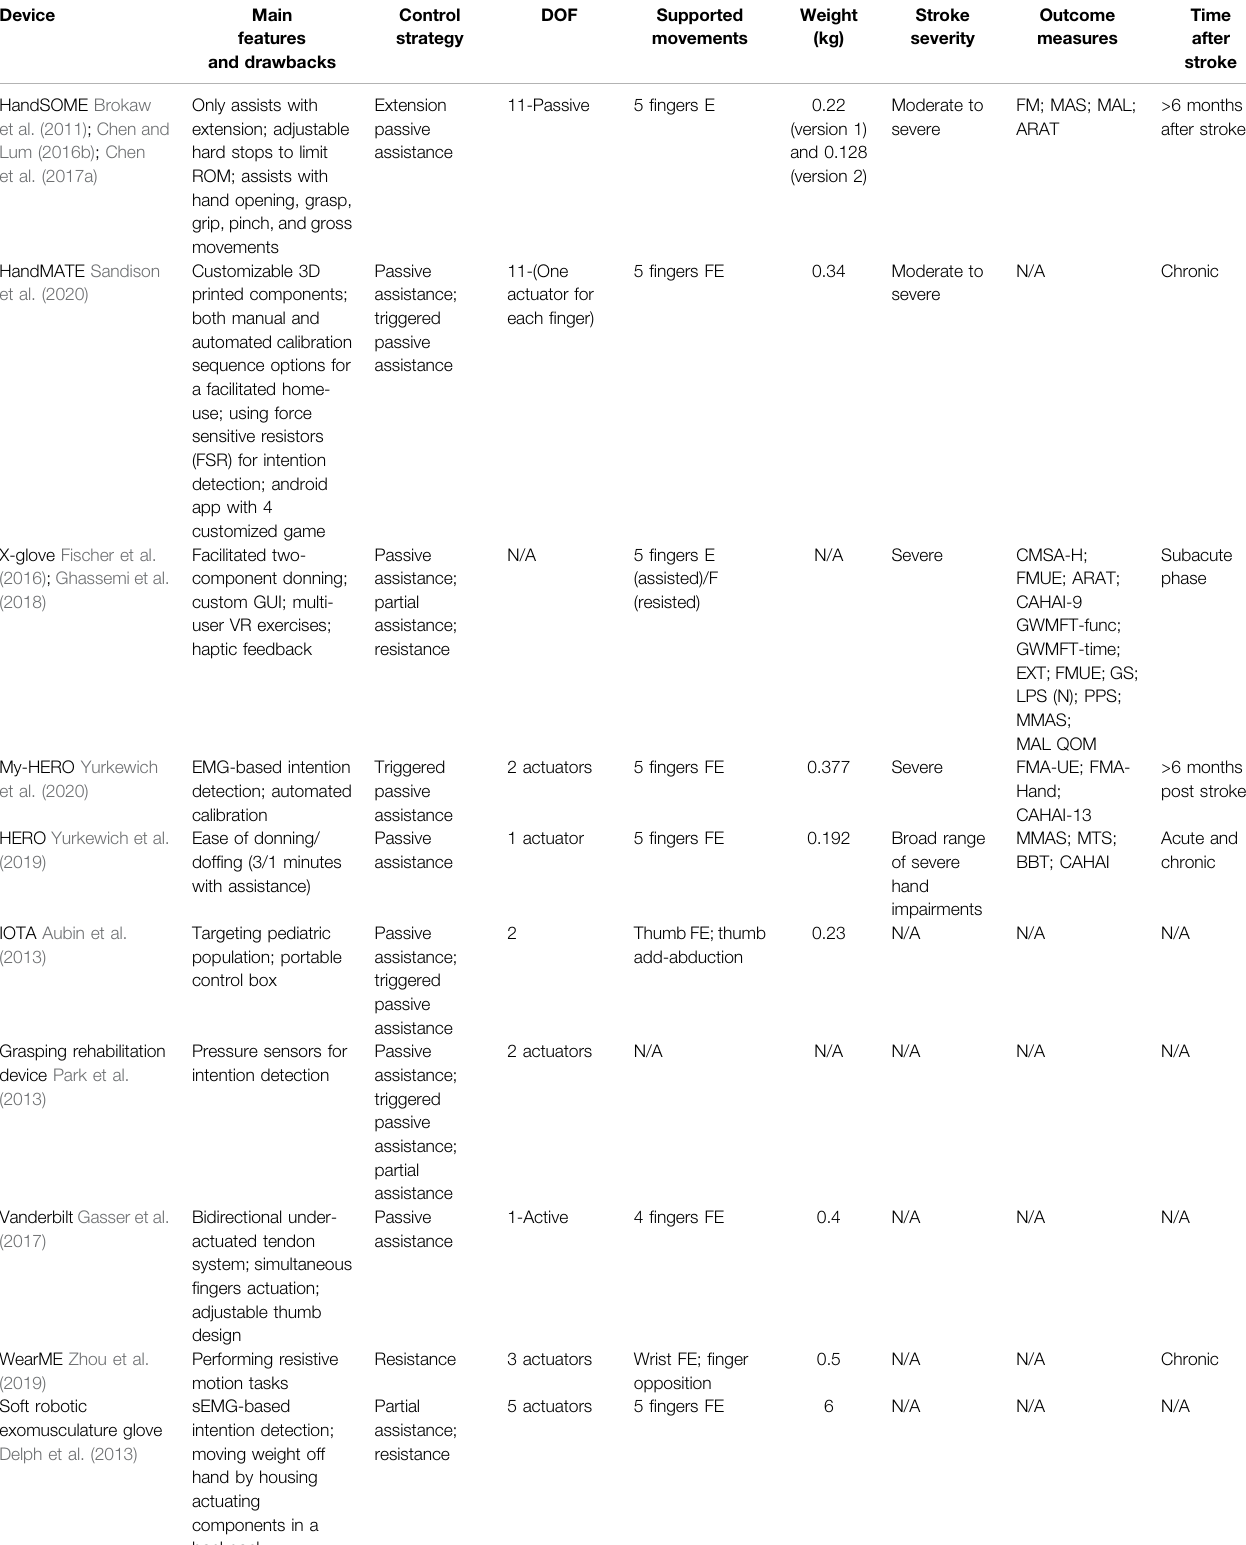
TABLE 1 | Summary of state-of-the-art robotic systems for home-based upper-limb rehabilitation.